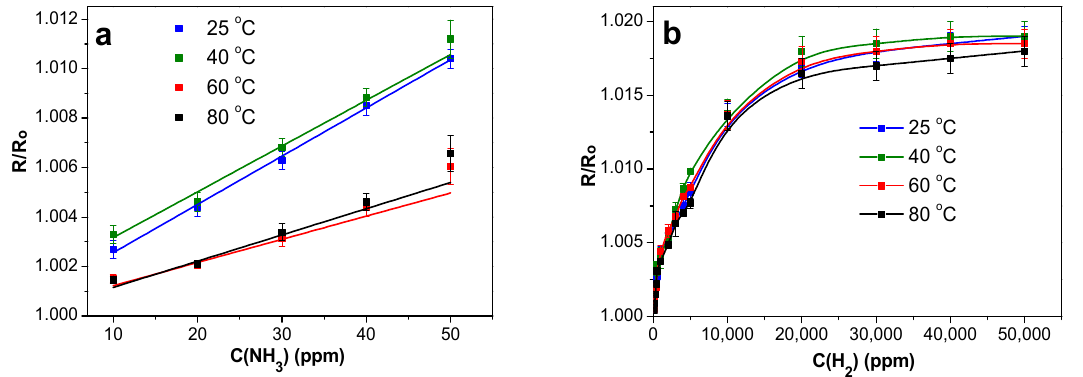
Figure 12. ( a ) Dependence of the sensor response of SWCNT / SiPc layers on concentration of NH 3 and ( b ) H 2 measured at different temperatures at RH 5%.